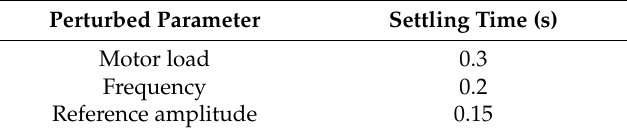
Table 5. Average settling time for different perturbations.